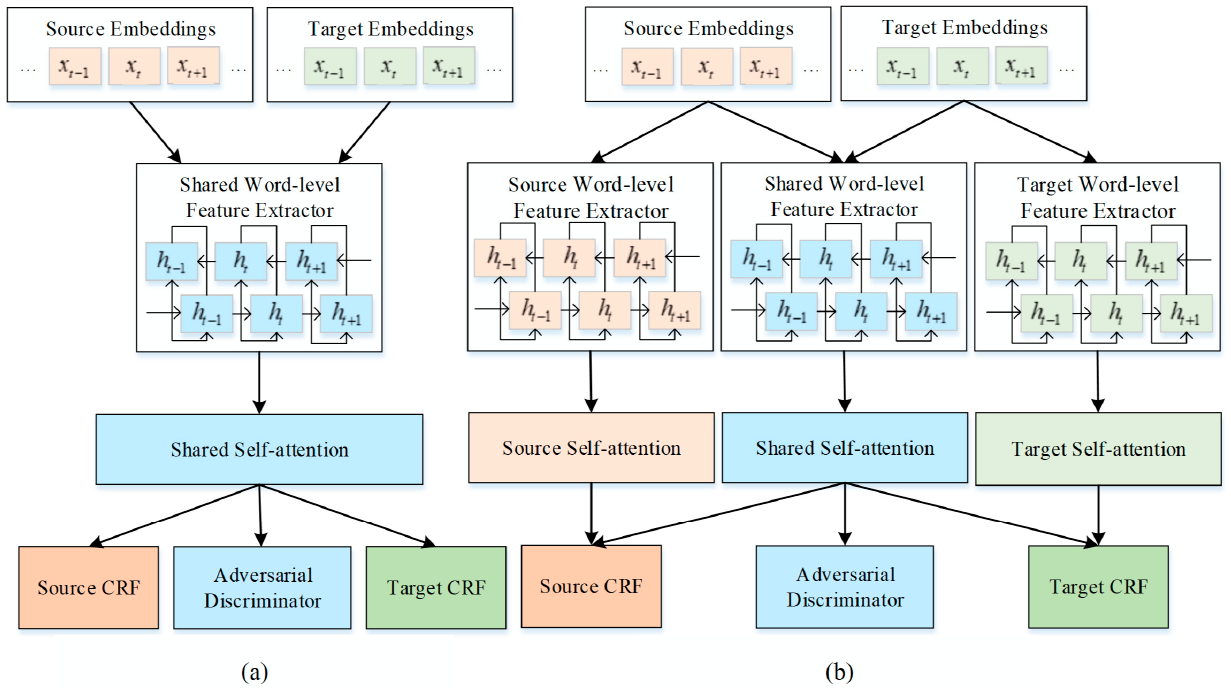
Figure 1. Adversarial transfer learning model diagram ( a ) full sharing mode ( b ) private sharing mode.